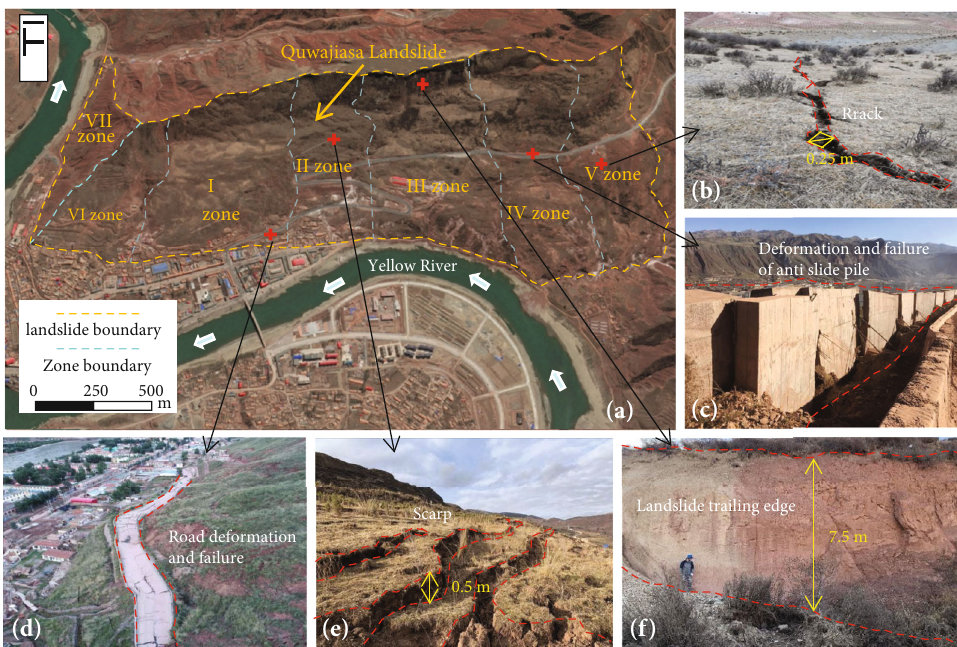
Figure 2: (a) Engineering geological zones of landslide. (b) Intermediate crack. (c) Deformation of antislide pile. (d) The deformation of the path. (e) Central scarp. (f) Landslide trailing edge.